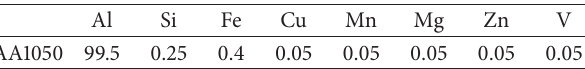
Figure 3: Schematic of the tool types, (a) pinless tool and (b) tool with a pin.